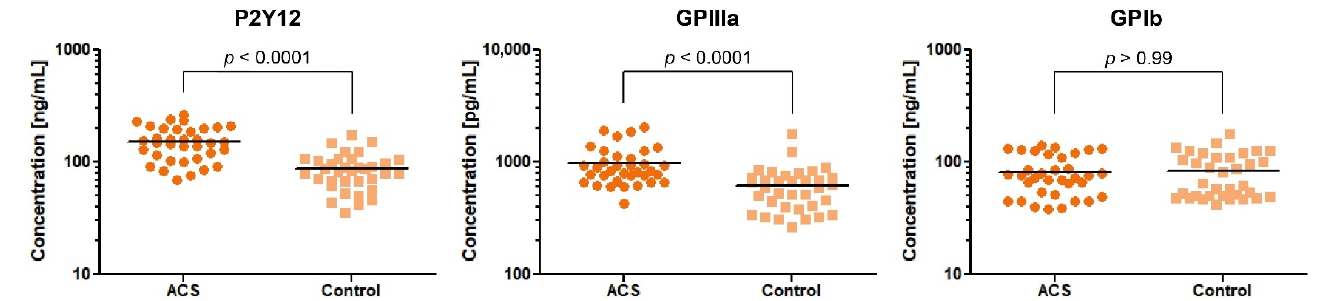
Figure 2. Levels of P2Y12, GPIIIa, and GPIb proteins in blood platelet lysates from ACS patients compared with the control group. Data are plotted as individual values with horizontal bars presenting the mean concentration. The p -values reported above the graphs represent the results of t -tests following log-transformation.